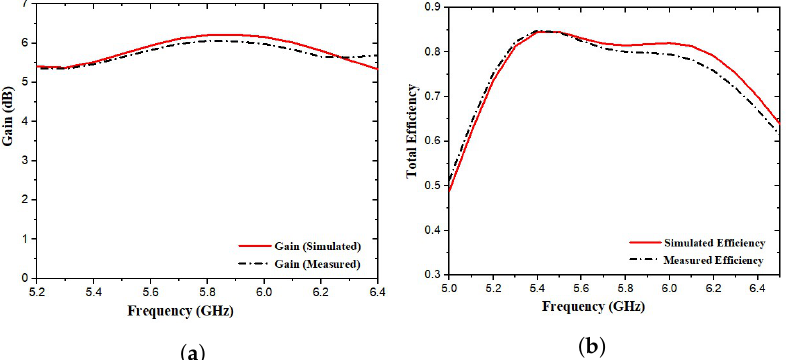
Figure 13. ( a ) Simulated and measured gain of the proposed antenna. ( b ) Simulated and measured radiation efficiency of the proposed